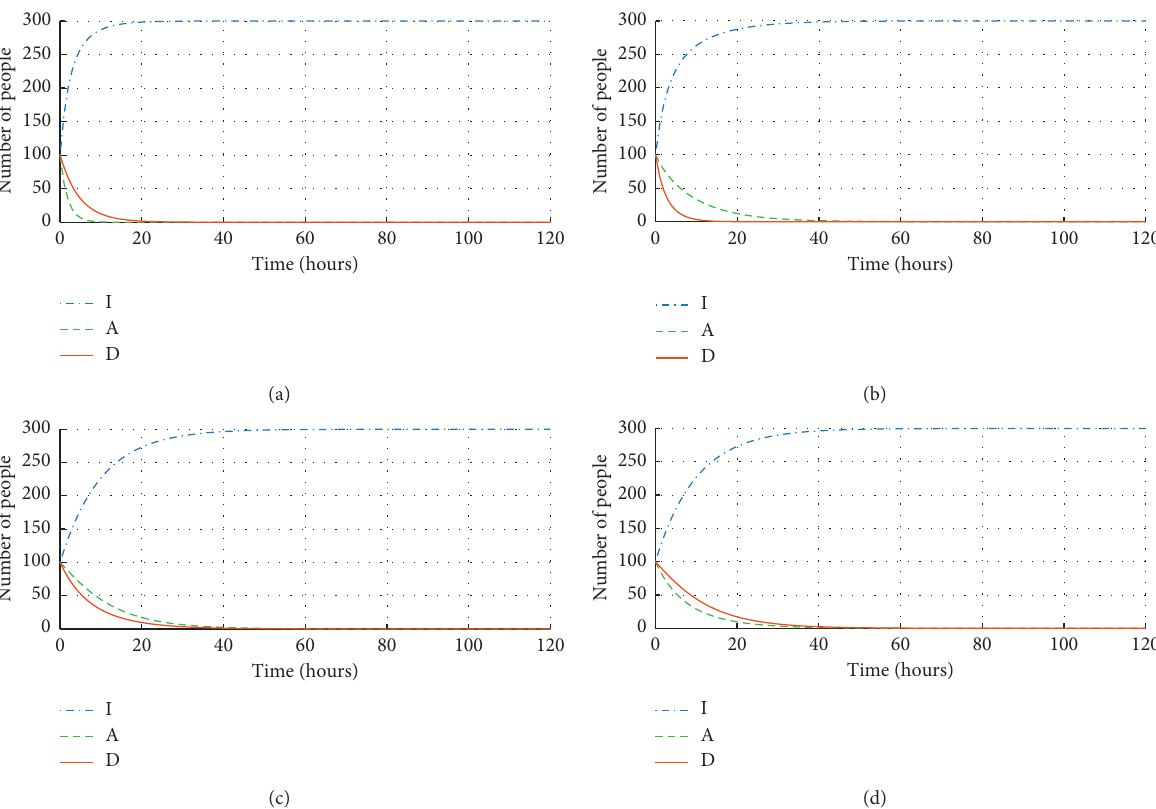
Figure 3: Examples of the steady state E I ( 0 ) � 100 , A ( 0 ) � 100, and D ( 0 ) � 100 and parameters’ values 0 simulated with initial conditions from Table 3. (a) Example 1. (b) Example 2. (c) Example 3. (d) Example